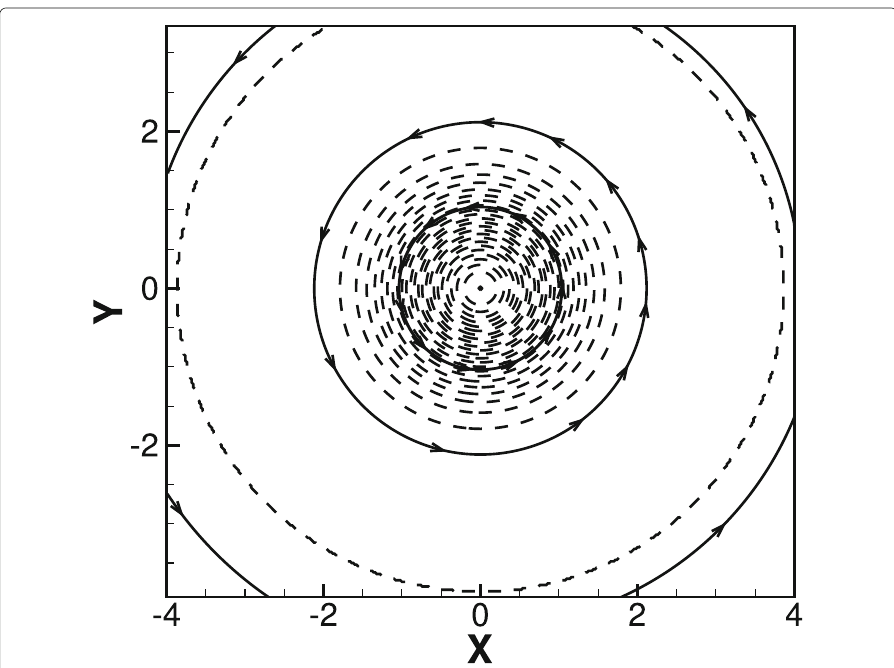
Fig. 5 Reproduced from [15]. The density contours (dashed lines from 0.9 to 1.0 with 30 levels) and streamlines (solid lines with arrows) of a two-dimensional isentropic